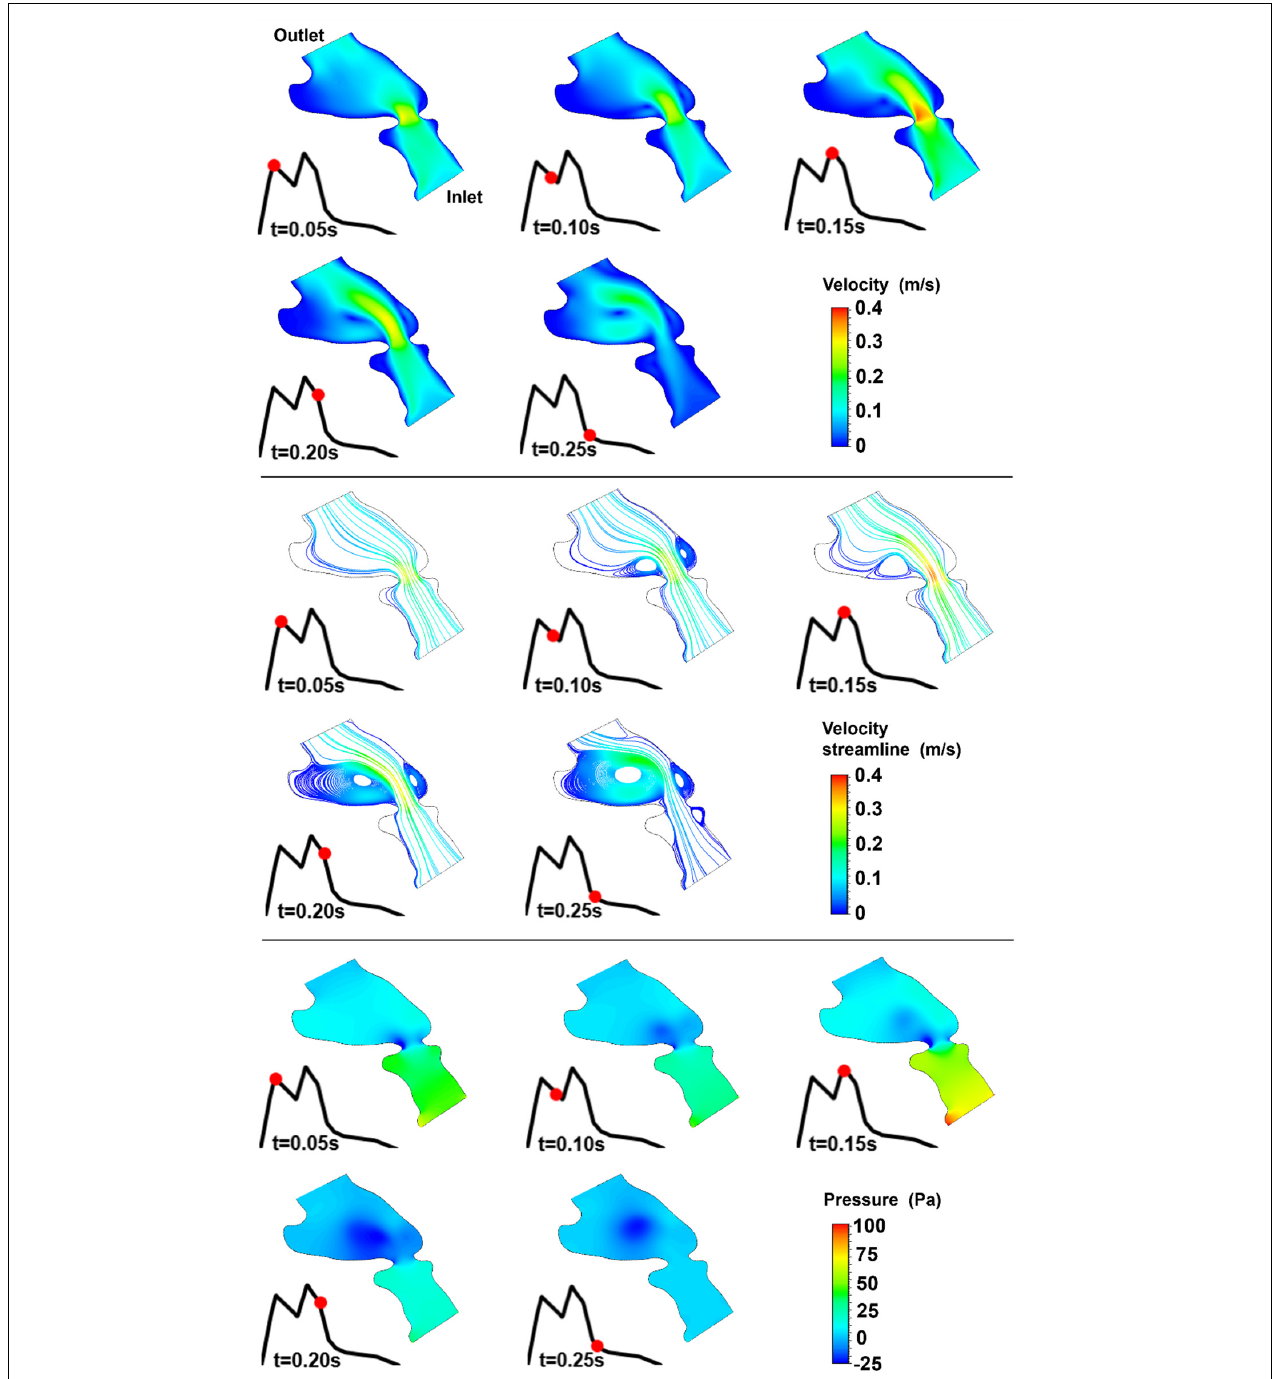
FIGURE 11 | Velocity magnitude, velocity streamline, and pressure contours for the control 4 heart at week 19. The instant in the cardiac cycle is shown near the plots.